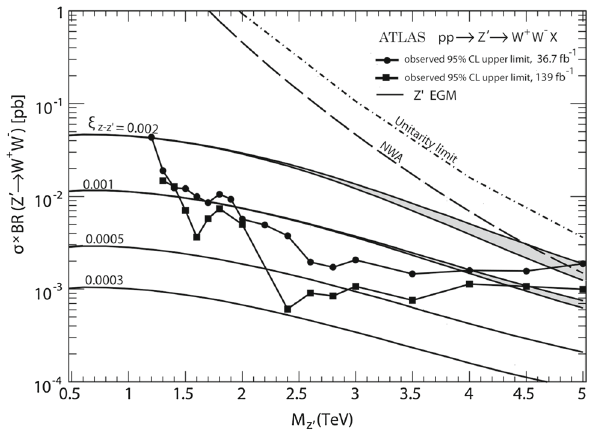
Fig. 6 95%CLexclusionregionsinthetwo-dimensional( M Z (cid:2) , ξ Z − Z (cid:2) ) plane obtained after incorporating direct search constraints from the CDF and D0 collaborations which are referred to as Tevatron (the dark shadedarea)in p ¯ p → W + W − X aswellasthosederivedfromtheLHC measurement of pp → WW X in Run 1 (the gray area) [56] and 13 TeV from diboson Z (cid:2) → WW production in hadronic final states using the partialandfull Run2ATLAS dataset.Alsoshown istheexclusionfrom the precision electroweak (EW) data [17]. Limits obtained from the semileptonic channel (cid:2)ν qq at time-integrated luminosity of 36 . 1 fb − 1 [39] are overlaid for comparison. Combined exclusion region for the EGM Z (cid:2) boson obtained after incorporating direct search constraints from the LHC Run 2 data set is shown as the light shaded area. The uninarity limit is shown as a dot-dashed